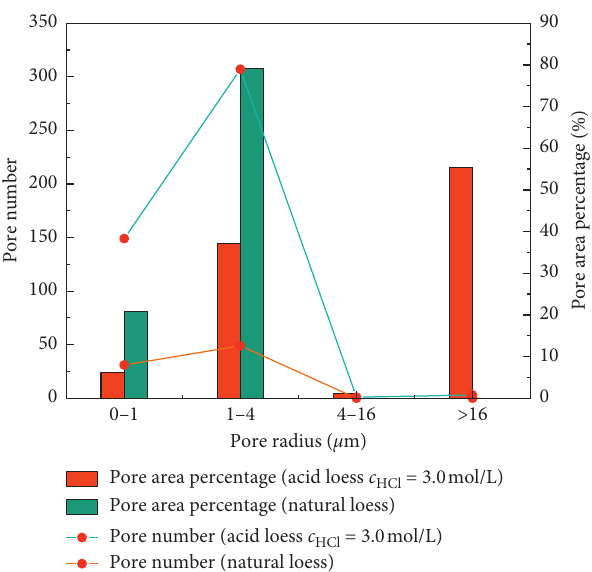
Figure 11: Variation of sample pore